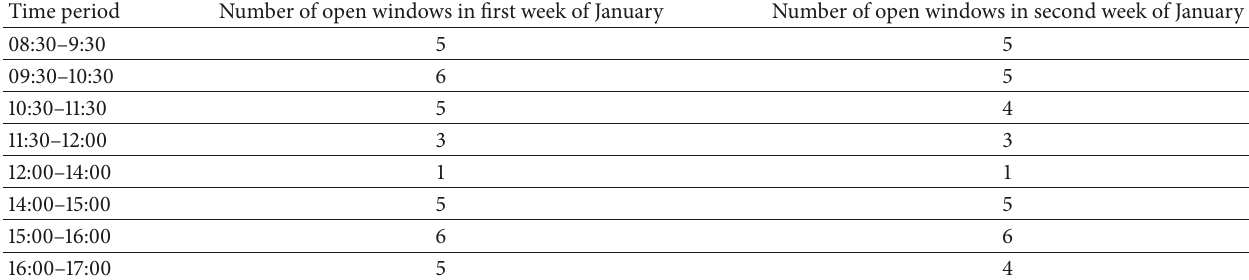
Table 2: Number of open